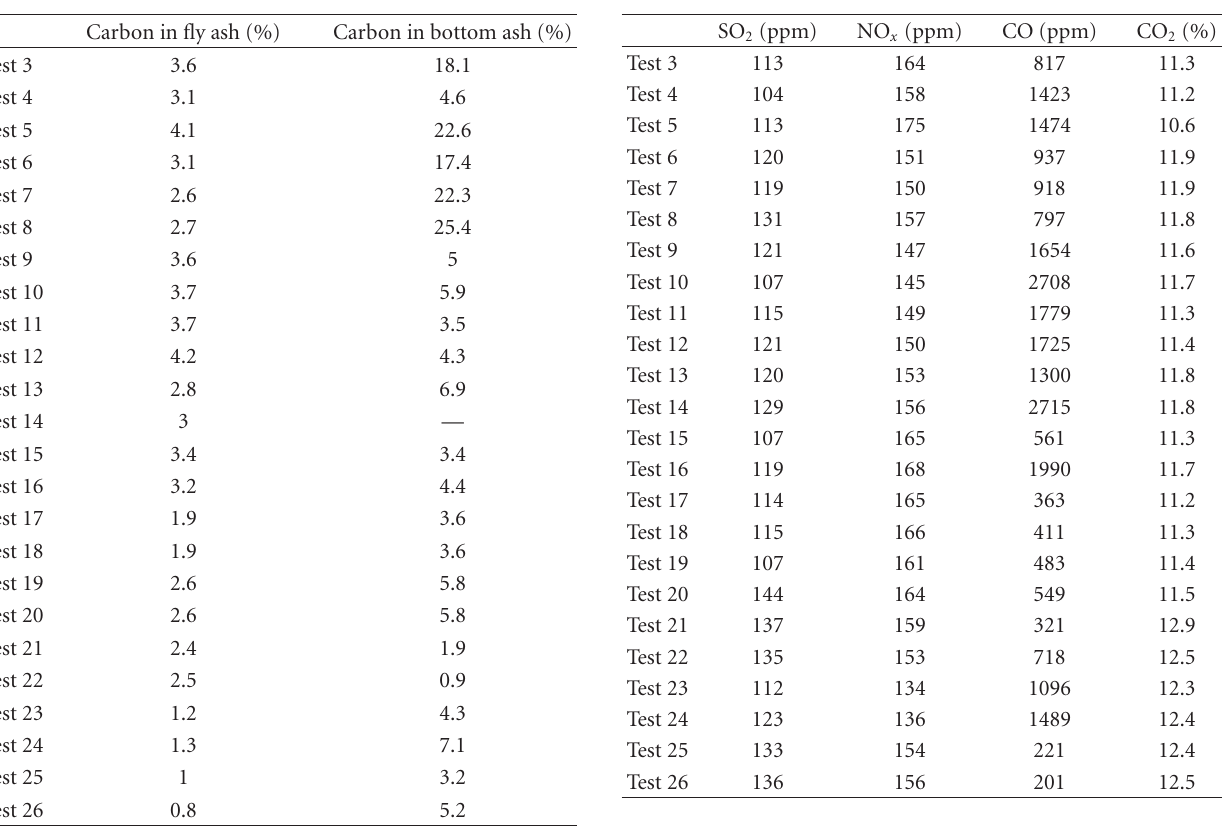
Table 3: Carbon content (dry basis) of fly ash and bottom ash. Table 4: Stack gas emissions